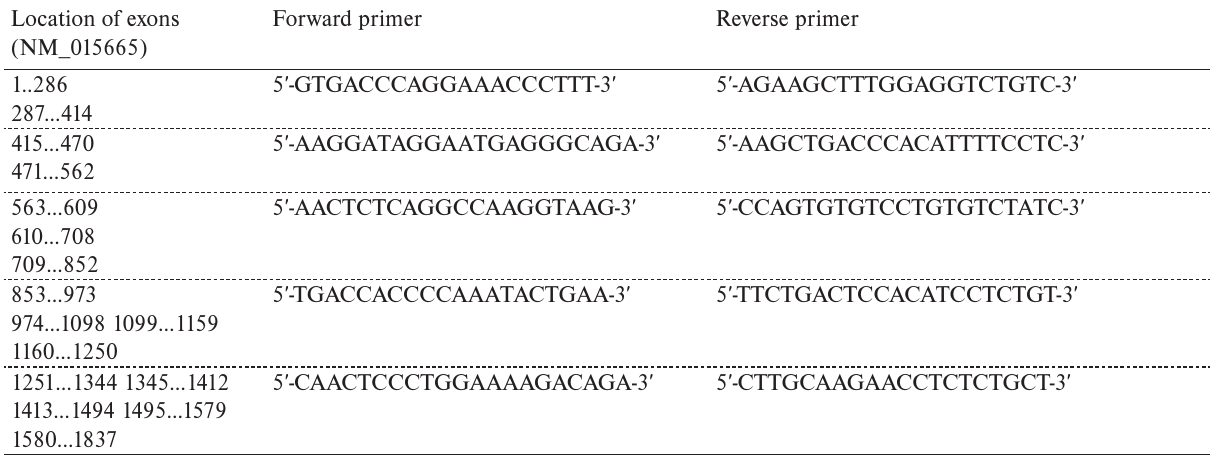
Table 2. Common polymorphisms in the genes associated with acromegaly found in the patient. Gene Variant